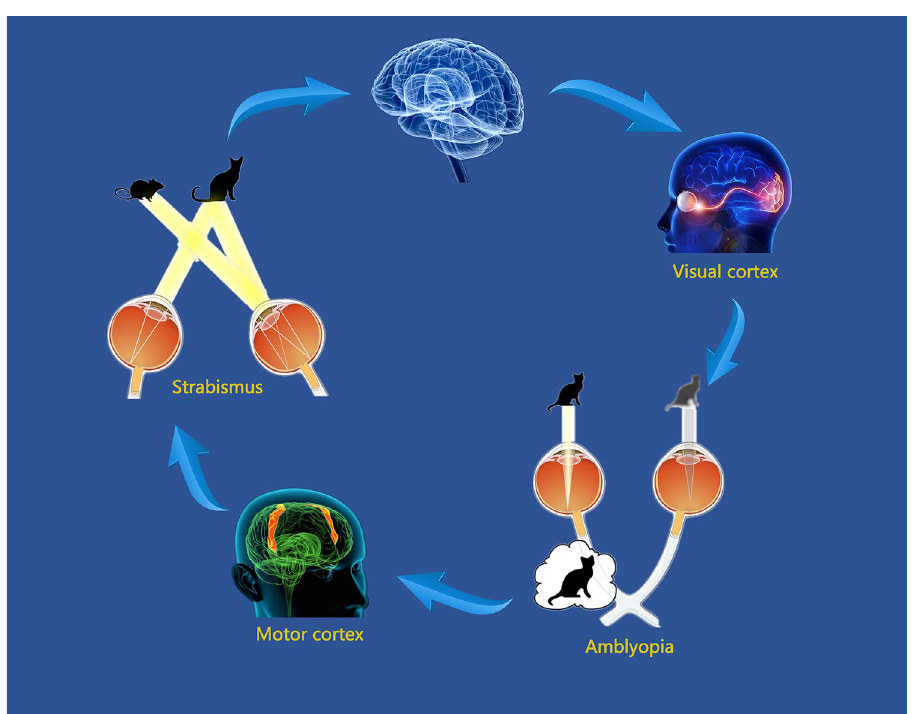
Figure 3. Relationship between MRI images and strabismus with amblyopia. Notes : Amblyopia is strongly correlated with the presence of strabismus during early childhood. Early aberrant visual experience could obstruct interocular alignment and ocular movement, leading to strabismus, and disturbing the sensory and visual cortex development might result in amblyopia.